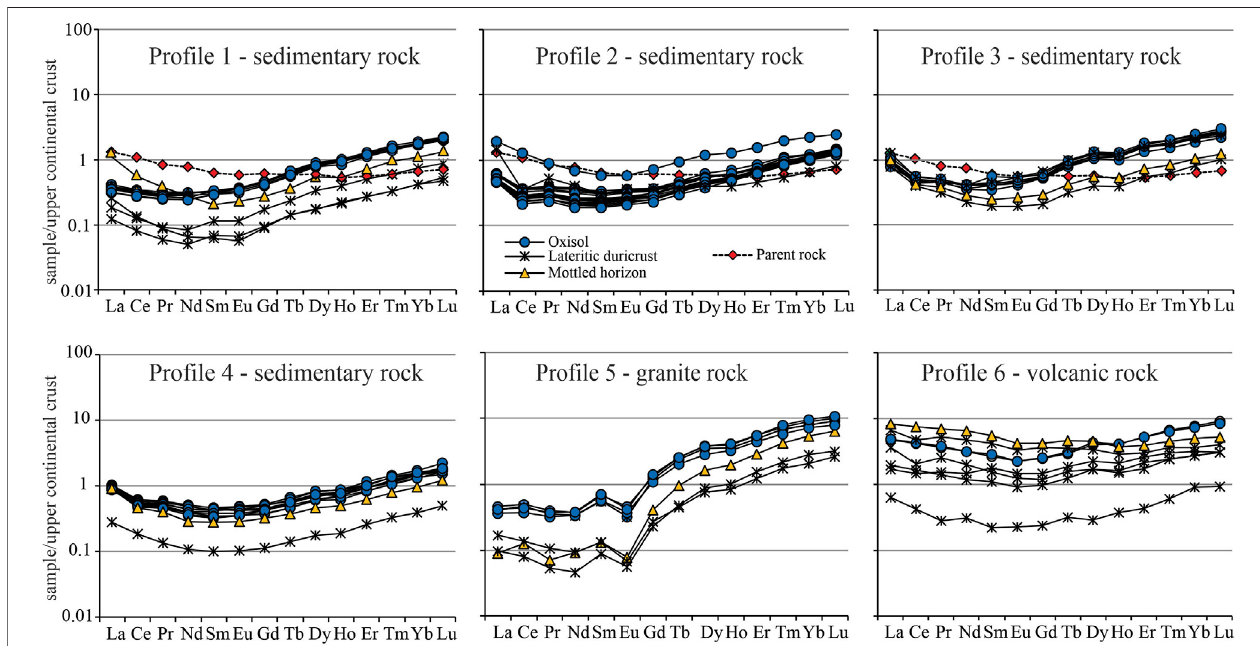
FIGURE 4 | Plot of REE expressed as ppm normalized to the estimated average composition of upper continental crust (UCC) of Taylor and McLenann (1985). In general, the lateritic duricrusts are less enriched in REE than the Oxisol, the mottled horizon, and the parent rock.